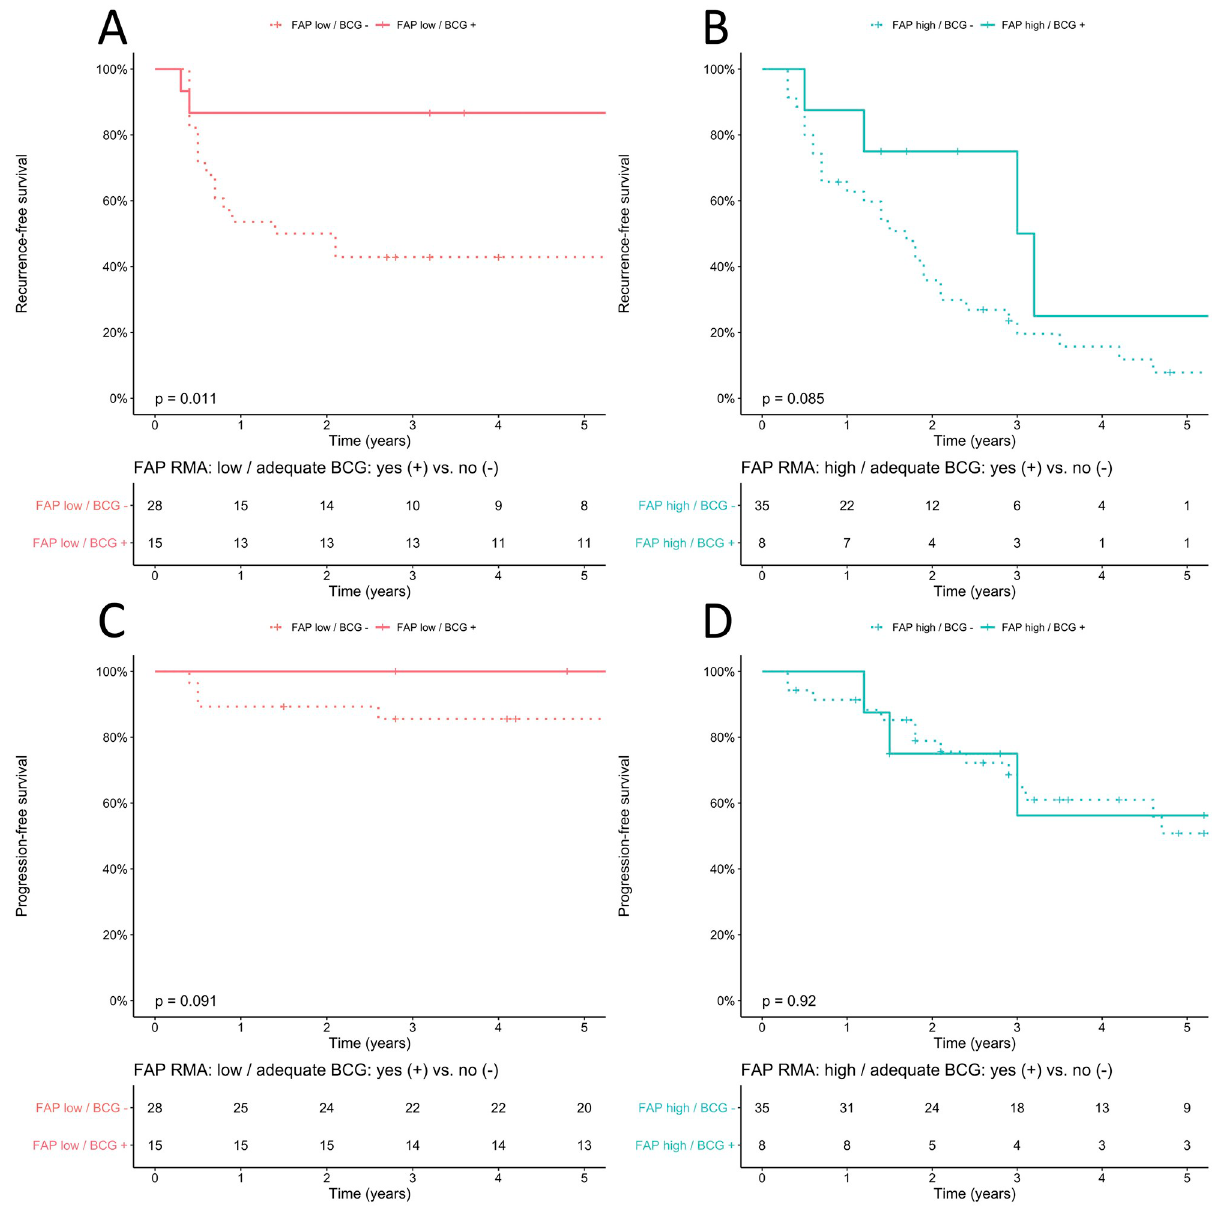
Fig 4. Kaplan-Meier plot of recurrence-free survival (RFS), or progression-free survival (PFS) stratified by adequate BCG (as defined by FDA; yes vs. no). Four groups are visualized: A: RFS for FAP low stratified by adequate BCG (n = 43), B: PFS for FAP high stratified by adequate BCG (n = 43), C: PFS for FAP low stratified by adequate BCG (n = 43), D: PFS for FAP high stratified by adequate BCG (n = 43). There was a significant difference in RFS in FAP low patients stratified by adequate BCG (yes vs. no; p = 0.01).